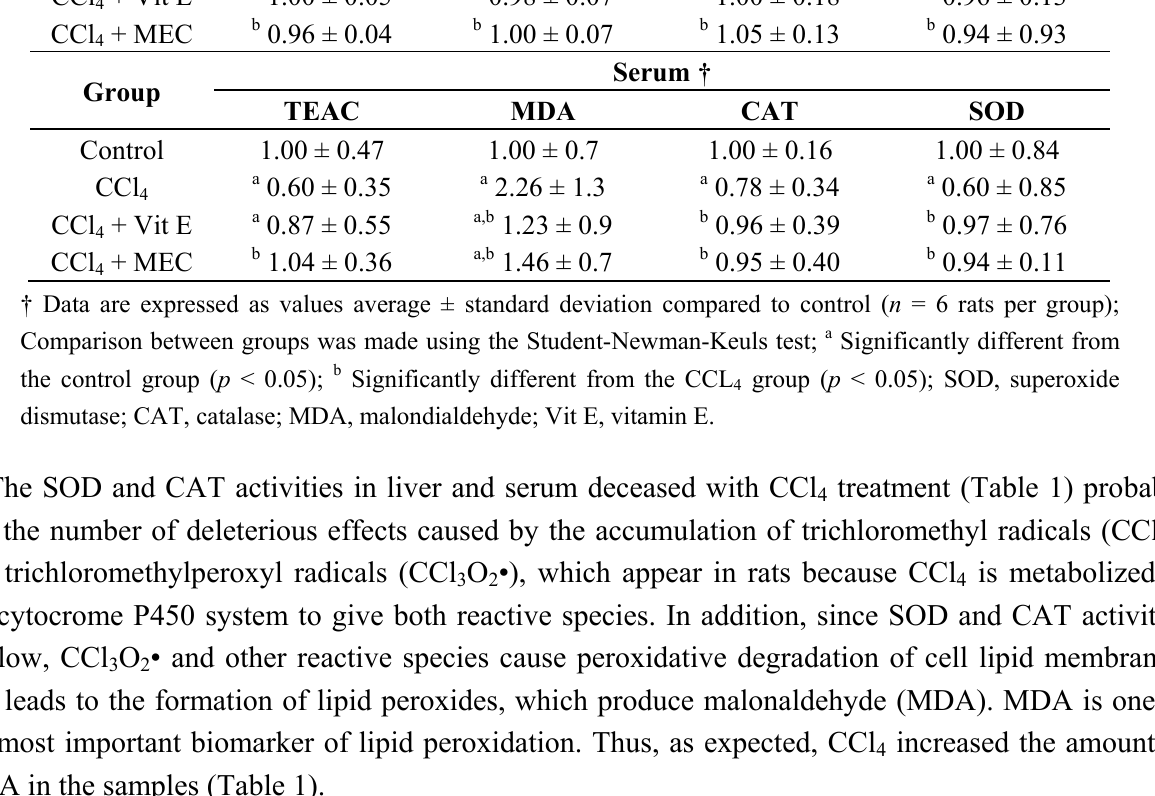
Table 1. Effect of MEC on liver and serum Trolox equivalent antioxidant capacity (TEAC), MDA, CAT and SOD in CCL4-intoxicated rat. Liver † Group TEAC MDA CAT SOD Control 1.00 ± 0.04 1.00 ± 0.04 1.00 ± 0.18 1.00 ± 0.16 a 0.65 ± 0.03 a 2.85 ± 0.15 a 0.50 ± 0.53 CCl 4 CCl + Vit E 4 b 0.94 ± 0.93 Serum † Group TEAC MDA CAT SOD Control 1.00 ± 0.47 1.00 ± 0.7 1.00 ± 0.16 1.00 ± 0.84 a 0.60 ± 0.35 a 2.26 ± 1.3 a 0.78 ± 0.34 a 0.60 ± 0.85 CCl 4 CCl + Vit E a 0.87 ± 0.55 a,b 1.23 ± 0.9 b 0.96 ± 0.39 b 0.97 ± 0.76 4 CCl + MEC b 1.04 ± 0.36 a,b 1.46 ± 0.7 b 0.95 ± 0.40 b 0.94 ± 0.11 4 Comparison between groups was made using the Student-Newman-Keuls test; a Significantly different from the control group ( p < 0.05); b Significantly different from the CCL group ( p < 0.05); SOD, 4